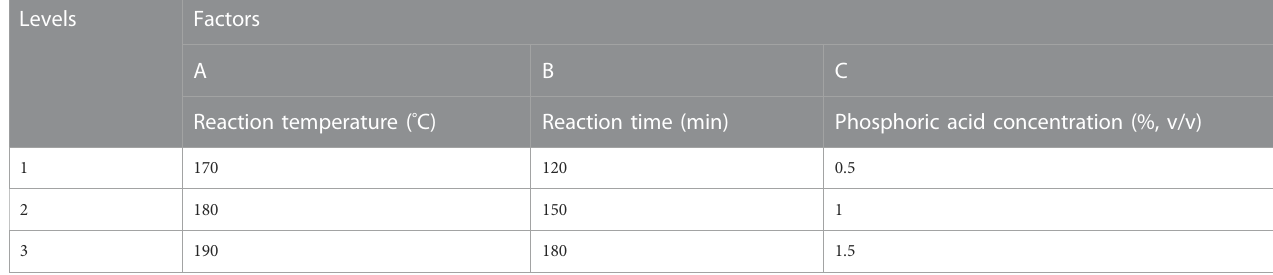
TABLE 1 The factors and levels of the pretreatment conditions.